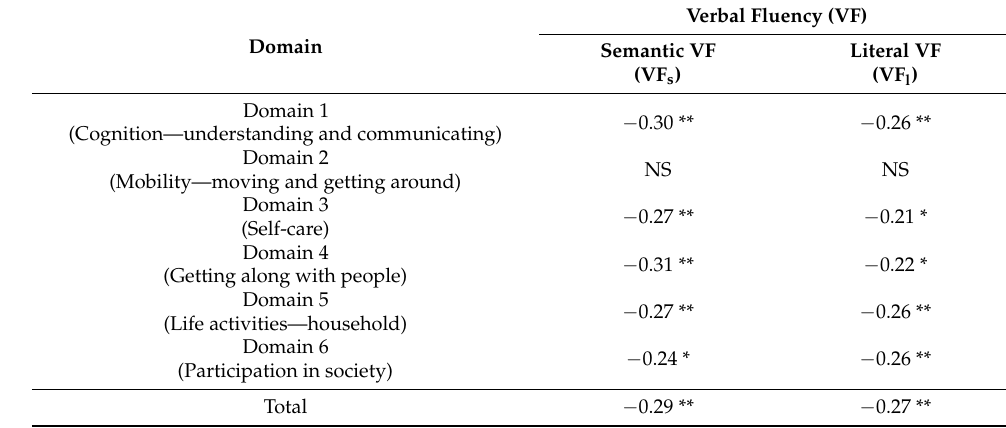
Table 6. Correlations with verbal